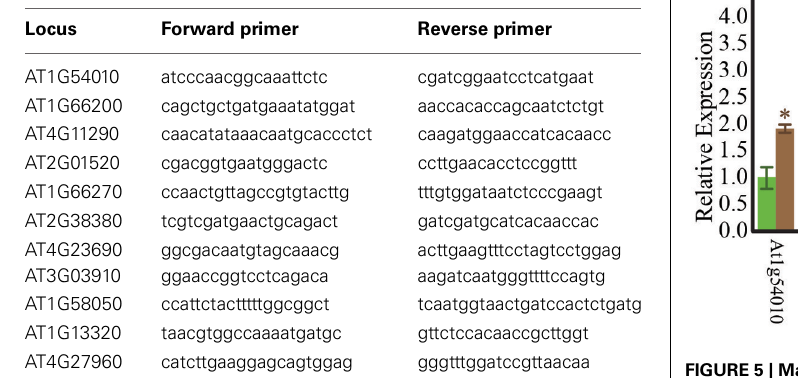
FIGURE 5 | Many genes whose protein levels are altered in toc132-4 mar 2 − 1 also show different transcript levels in toc132-4 mar 2 − 1 relative to wild type. The first five genes from left to right encode proteins that are found at an increased abundance in toc132-4 mar 2 − 1 , and the last three genes encode proteins that are found at decreased abundance in toc132-4 mar 2 − 1 . The expression of each candidate gene was quantified relative to a reference gene as described in the Materials and Methods section, and the expression of each gene in wild type was set to 1. The error bars represent the standard error among three biological replicates. The asterisks indicate significant differences between wild type